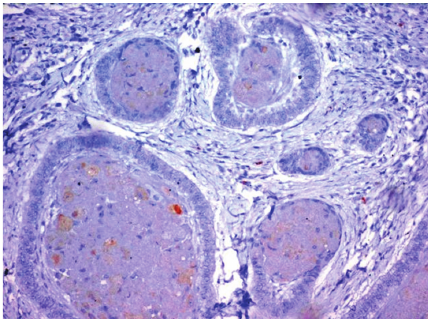
Figure 6: CD-68 showed a moderate to strong staining intensity in granular cells (20x).